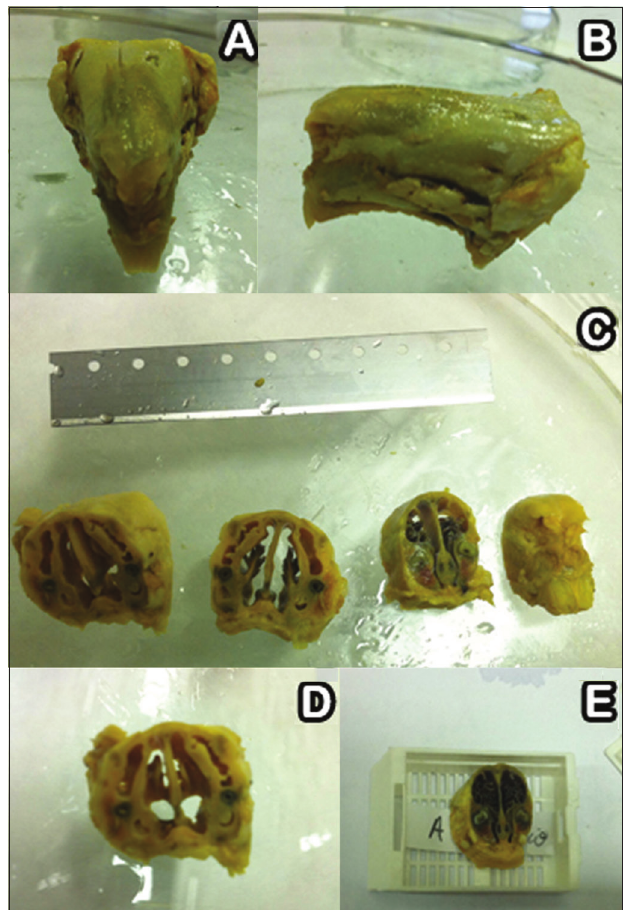
Figura 4. A-B: Meso-estrutura facial desidratada em formaldeído a 10%. C-E: Cortes seriados transversais do nariz ao crânio a cada dois